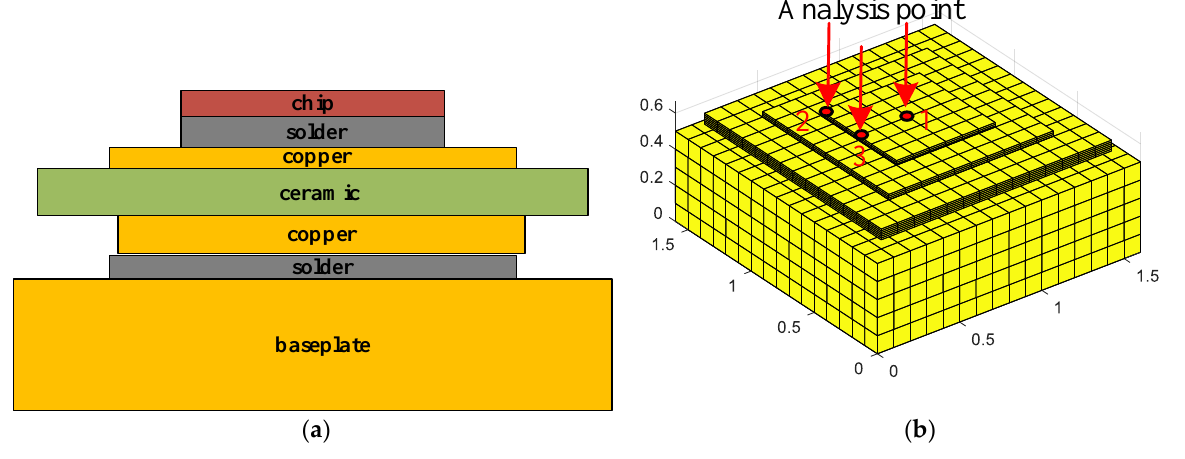
Figure 3. Prototype ( a ) IGBT module and its ( b ) NTM model.